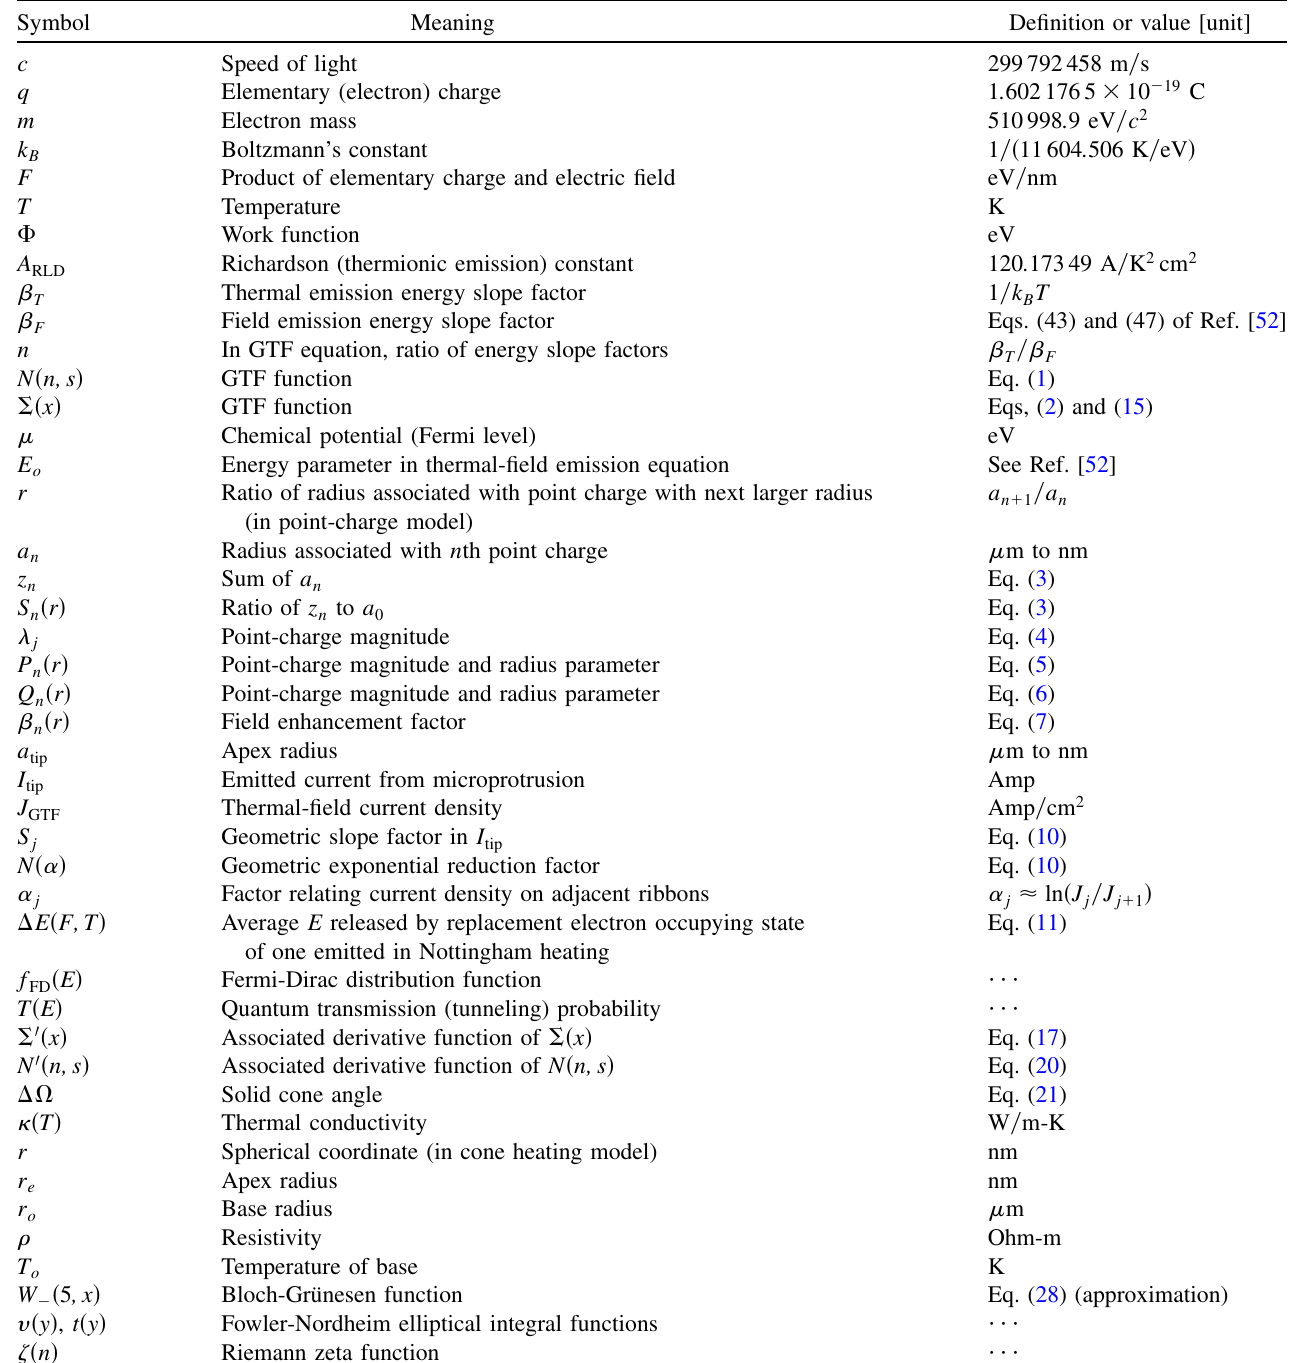
TABLE I. Entries are given in the approximate order of their first use. MKSA units are used unless otherwise specified.